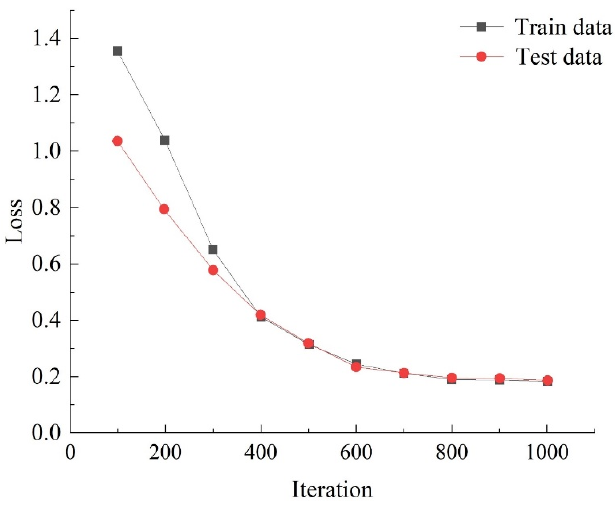
Figure 8. The change in values in the CNN ‐ SVM model loss training and testing set.